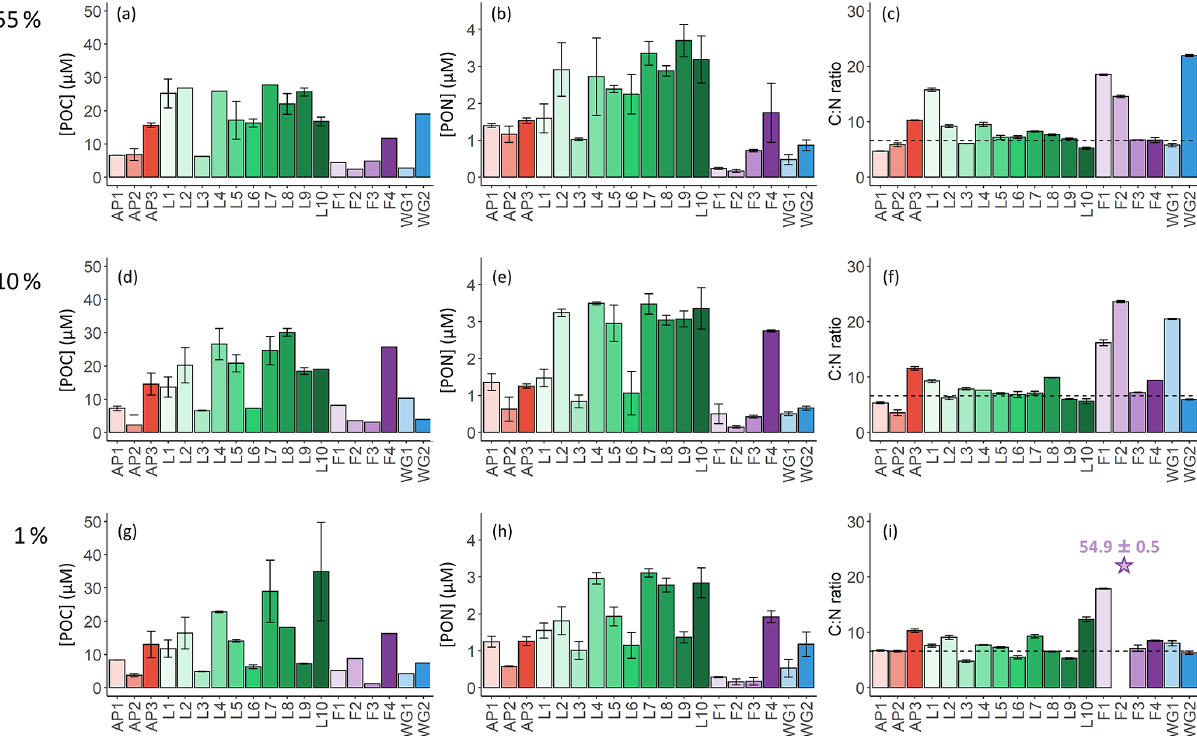
Figure 5. Bar plots of (a, d, g) POC concentrations, (b, e, h) PON concentrations, and (c, f, i) biomass C : N ratios measured at the 55% (a–c) , 10% (d–f) , and 1% light levels (g–i) . The stations are labelled on the x axis, and the general station locations are indicated by the different colours: red shades – Antarctic Peninsula, green shades – Larsen C Ice Shelf, blue shades – Weddell Gyre, light purple shades – early-summer Fimbul Ice Shelf, and dark purple – late-summer Fimbul Ice Shelf. The dotted black horizontal line in panels (c) , (f) , and (i) shows the Redfield C : N ratio of 6.63. The purple star in panel (i) indicates the anomalously high C : N ratio estimated for the 1% PAR depth at station F2. The error bars represent ± 1 SD of replicate samples ( n = [ 2 , 6 ] ). Where applicable, the error has been propagated according to standard statistical